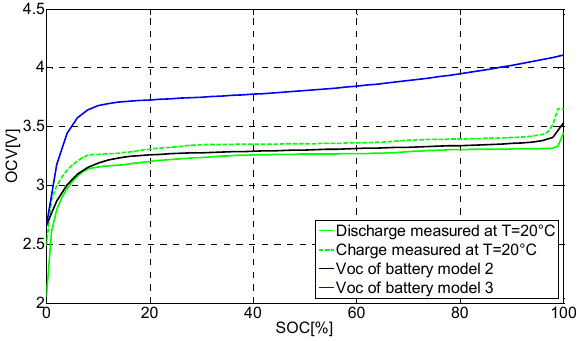
Figure 7. Comparing the V oc model with measured experimental results. Table 4. Accuracy of the proposed V OC model.